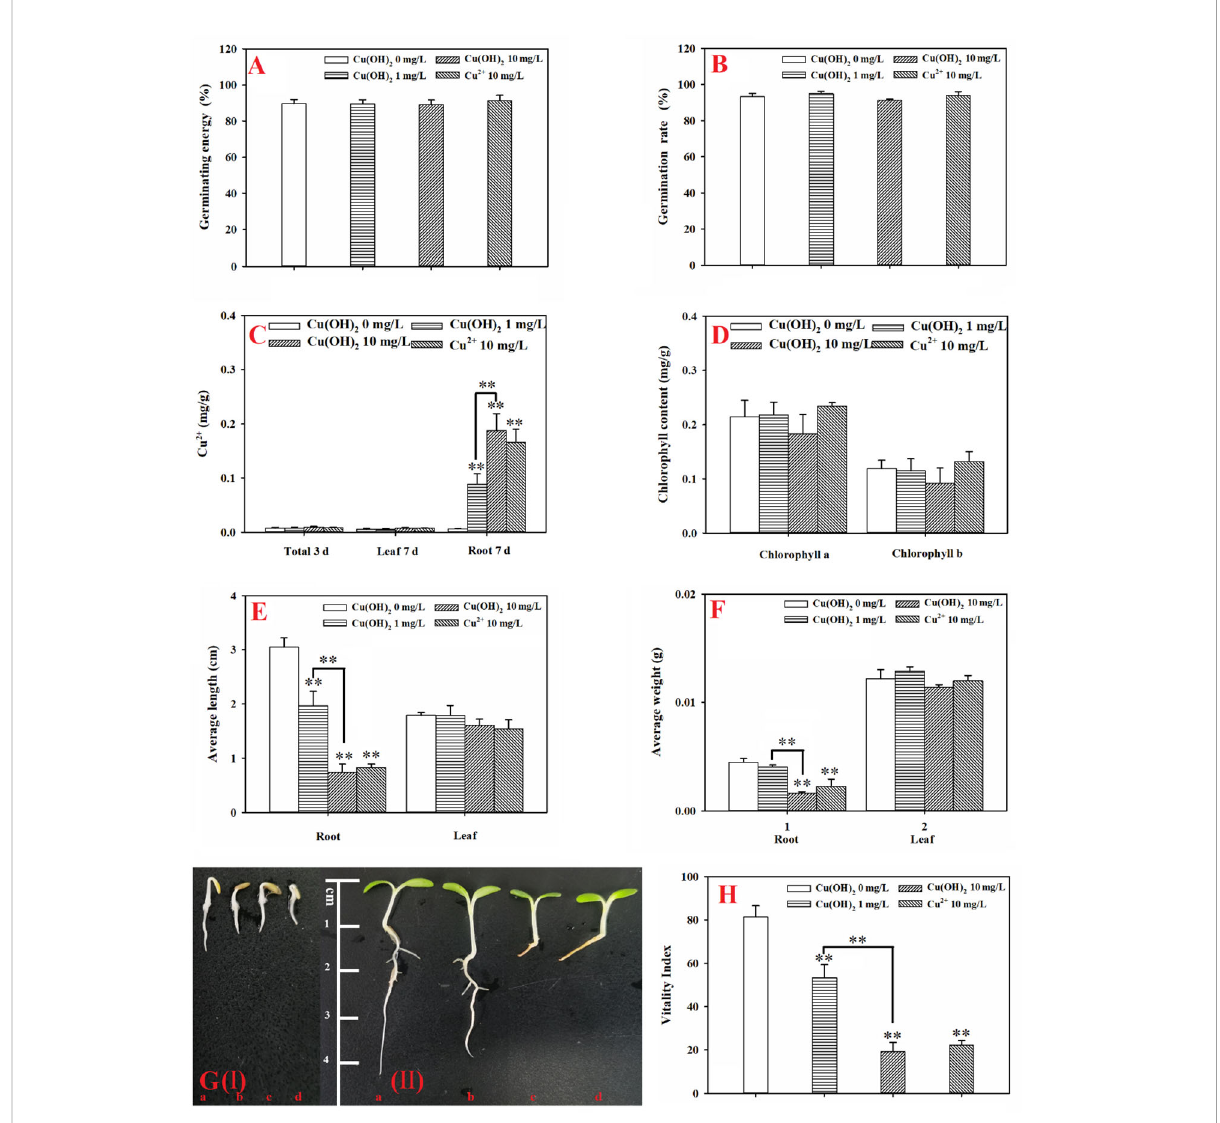
FIGURE 2 (A) : Germination energy of lettuce seeds under different treatments; (B) : germination rate of lettuce seeds under different treatments; (C) : accumulation of Cu in lettuce seeds (3 d) and seedling leaves and roots (7 d) under different treatments; (D) : chlorophyll content in seedling leaves (7 d) under different treatments; (E) : average length of roots and leaves (7 d) under different treatments; (F) : average weight of roots and leaves (7 d) under different treatments; (G) : lettuce seed germination at 3 days (I) and lettuce seedling growth at 7 days (II). The letters a, b, c, and d denote the control, 1 mg/L Cu (OH) 2 , 10 mg/L Cu(OH) 2 , and 10 mg/L Cu 2+ treatment groups, respectively; and (H) vigor index of lettuce seeds (7 d) under different treatments. The data are presented as the mean ± SD from at least four replicates. ** means extremely signi fi cant